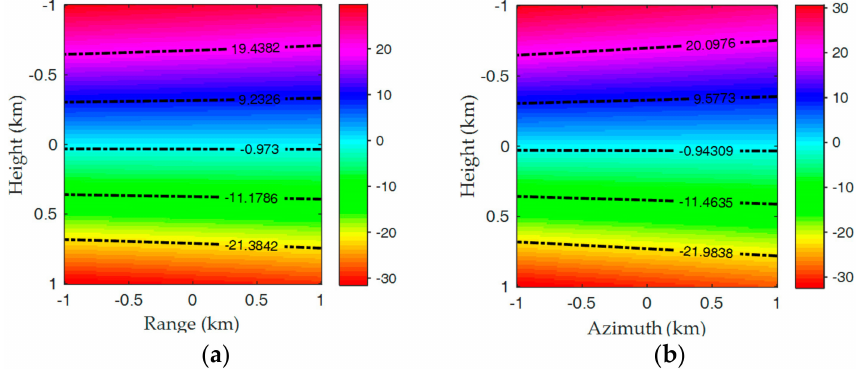
Figure 3. PEs introduced by topography variations in different domains: ( a ) PEs introduced by topography variations in the range/height domain; ( b ) PEs introduced by topography variations in the azimuth/height